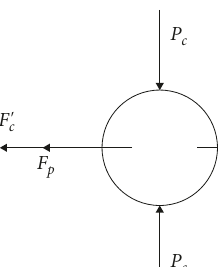
Figure 10: Analysis of proppant stress during gas injection.